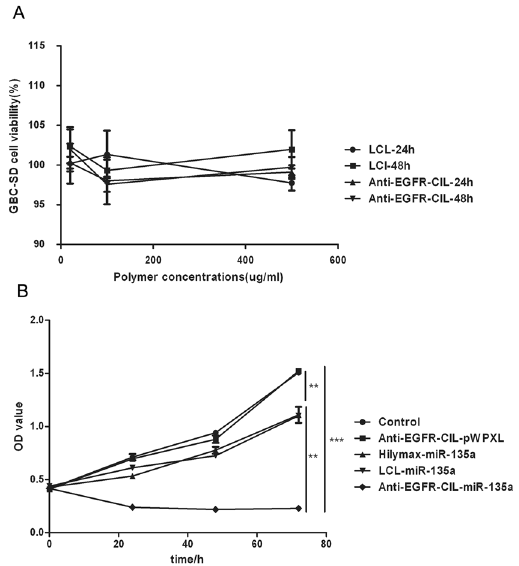
Figure 4. Liposome cytotoxicity. GBC-SD cells were incubated for 24 or 48 hours with varying concentrations of empty liposomes ( A ) and liposomes loaded with miR-135a at a concentration of 100 ng/ μ l for 24 hours ( B ). Cell viability was evaluated by performing a CCK-8 assay. Data (mean ± SD, n = 3) are representative of three independent